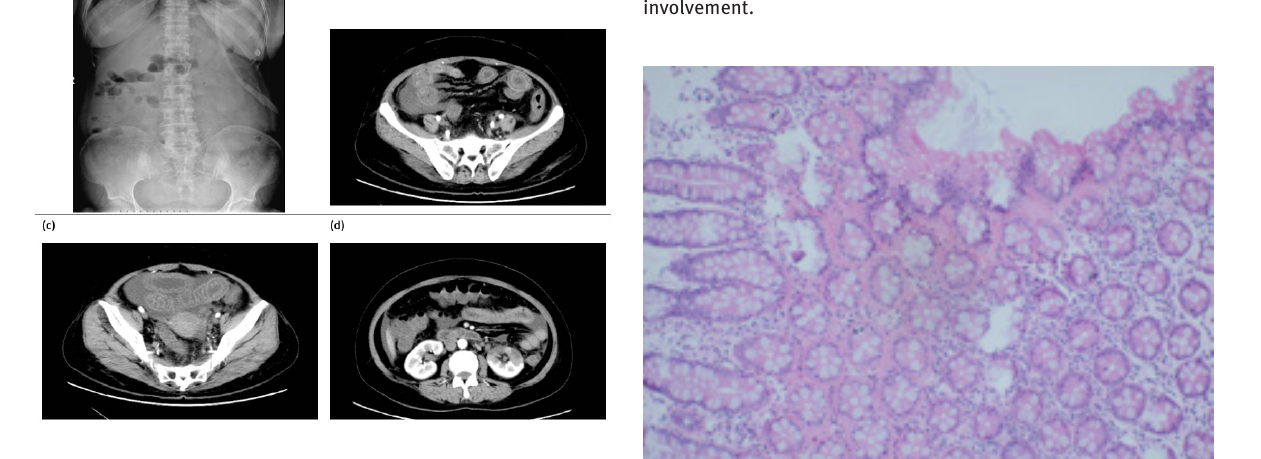
Figure 2. ( a) Deposition of fuchsinophilic protein in mesangial, subendothelial, subepithelial space. (b) Mesangial cells and matrix lightly proliferating, glomerular basement membrane widespread thickening. (c) Focal segmental mesangial cells and matrix lightly proliferating, glomerular basement membrane widespread thicke- ning, with a small cellular crescents, tubular epithelial vacuolar and granular degeneration, without renal interstitial and arteriole involvement. (d) Focal segmental mesangial cells and matrix lightly proliferating, glomerular basement membrane widespread thicke- ning, with a small cellular crescents, tubular epithelial vacuolar and granular degeneration, without renal interstitial and arteriole